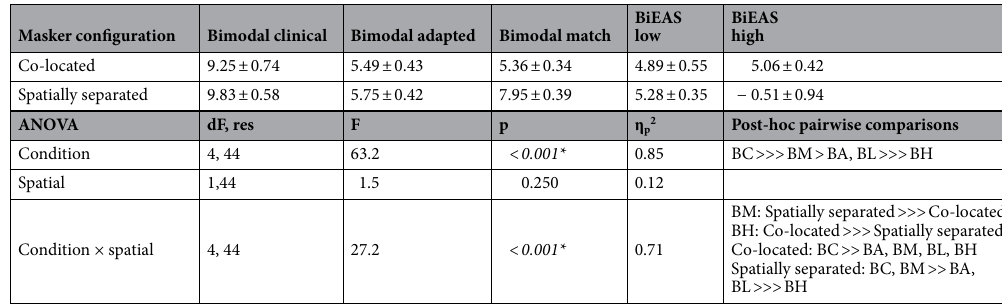
Table 1. Top: Mean SRTs and standard deviation for the five listening conditions with co-located or spatially separated maskers. Bottom: Results of RM ANOVA on SRT data. Significant effects are indicated by italics and asterisks. Significant differences for Bonferroni-corrected pairwise comparisons are shown at right (> = p < 0.05; >> = p < 0.01; >>> = p < 0.001). SRT, speech recognition threshold; BC, bimodal clinical; BA, bimodal adapted; BM, bimodal match; BL, BiEAS low; BH, BiEAS